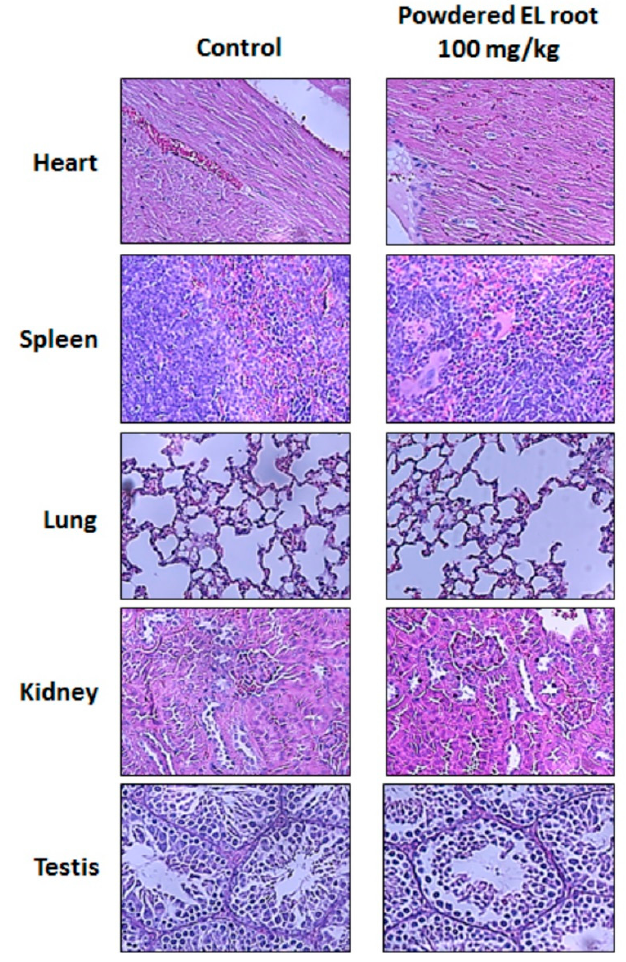
Figure A1. Histopathology examination on EL-treated db / db mice. Representative images showed that after 8 weeks treatment, there were no EL-related pathology signs in heart, spleen, lung, kidney, and